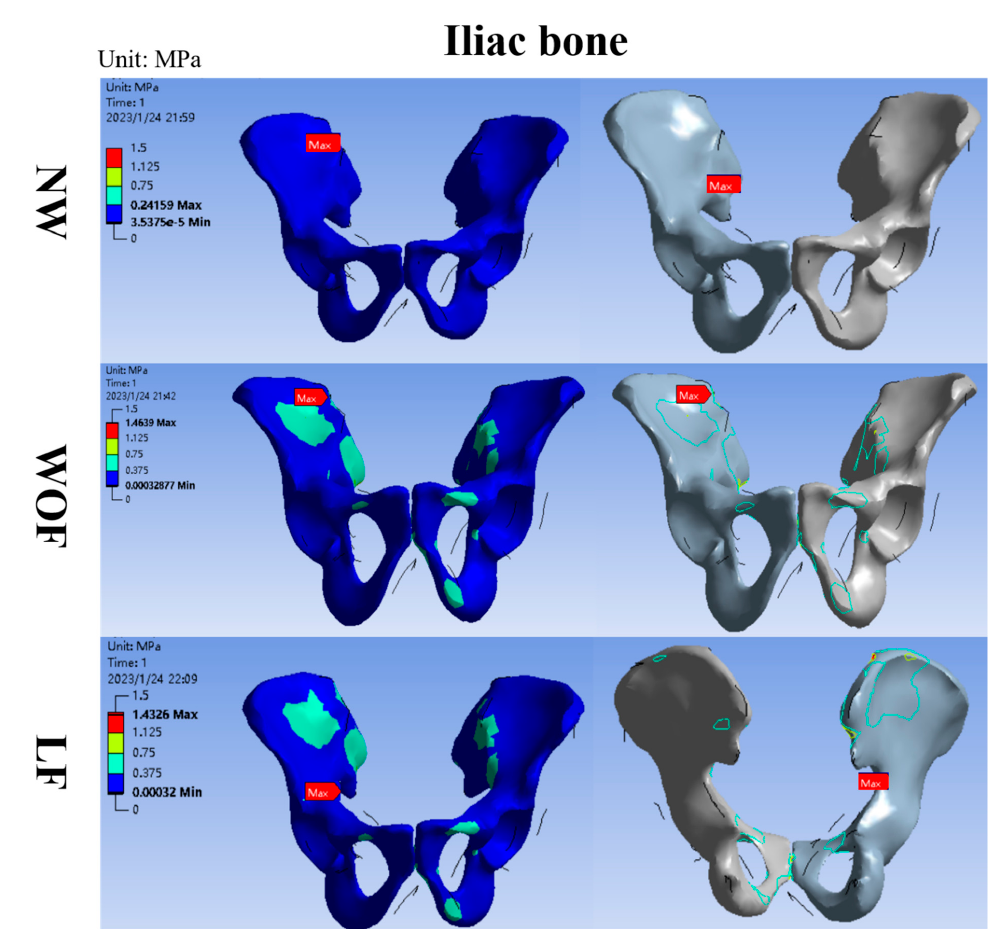
Figure 5. Iliac bone stress distribution cloud map. NW, normal walking; WOF, warding off with steps forward; LF, laying with steps forward. Equivalent stress distribution of the iliac bone during two progressive motions of Bafa Wubu and NW is shown. The warmer the color, the greater the stress. The red arrow indicates the maximum stress, and black lines around bones indicate their displacement distance.